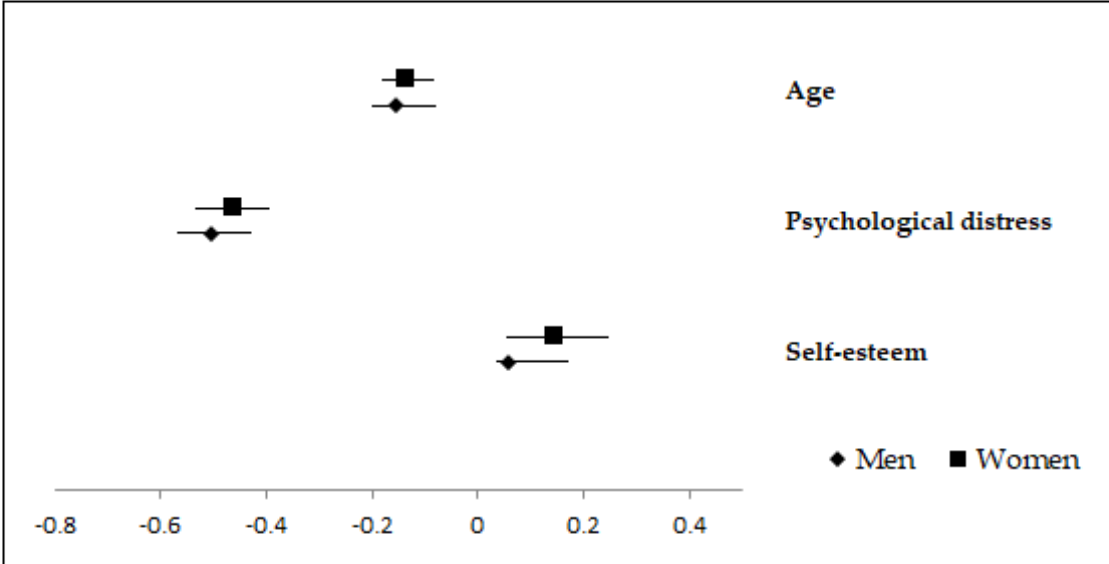
Figure 2. Beta values (95% CI) in the final model for men and women in the regression predicting social functioning.